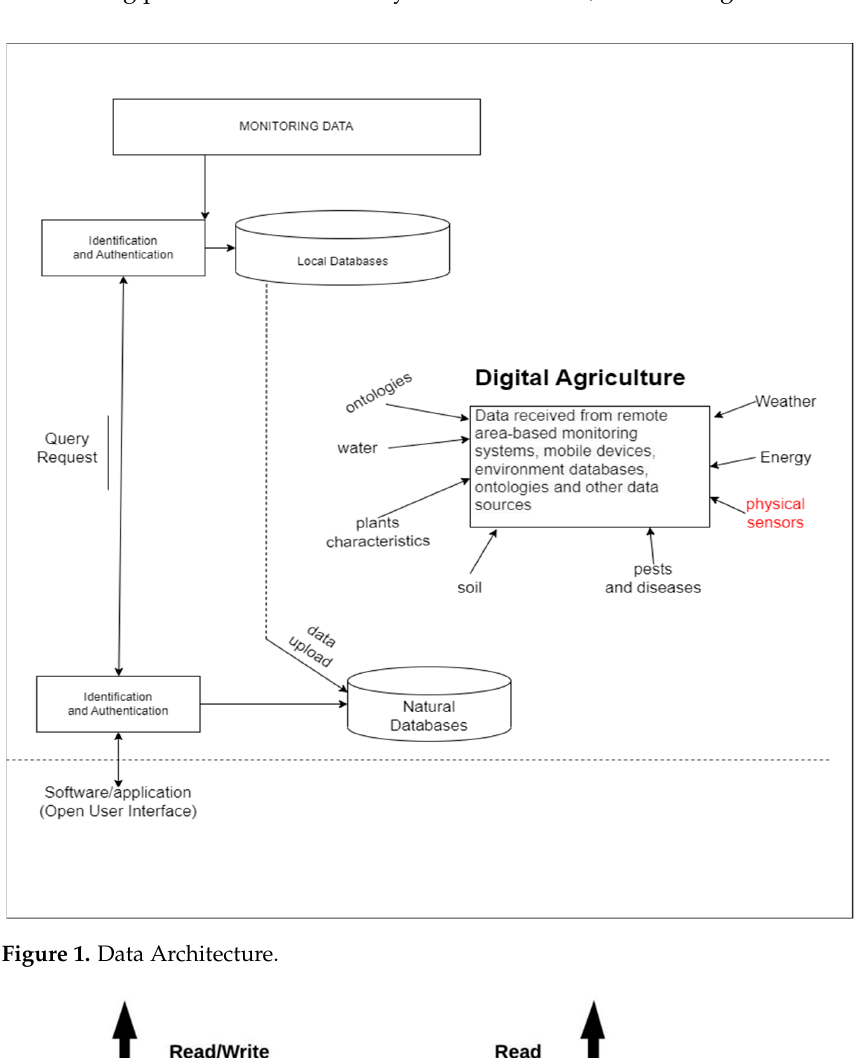
Figure 1. Data Architecture.